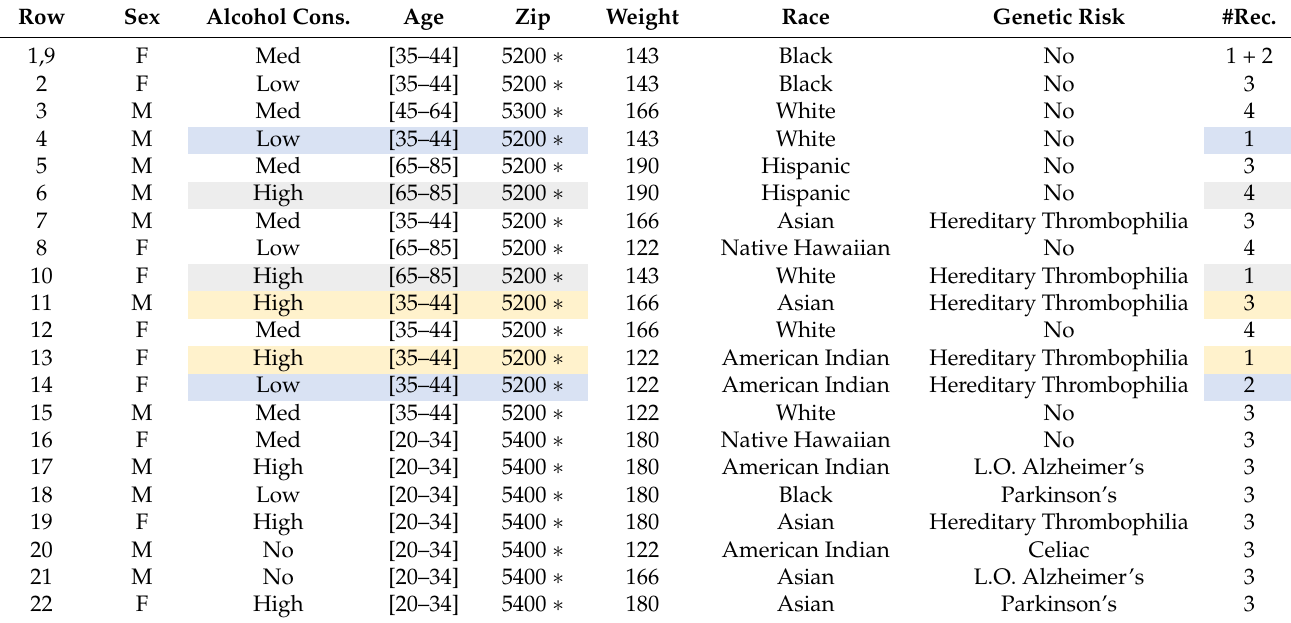
Table 5. Anonymized table from Exhaustive (Method 1) and Our